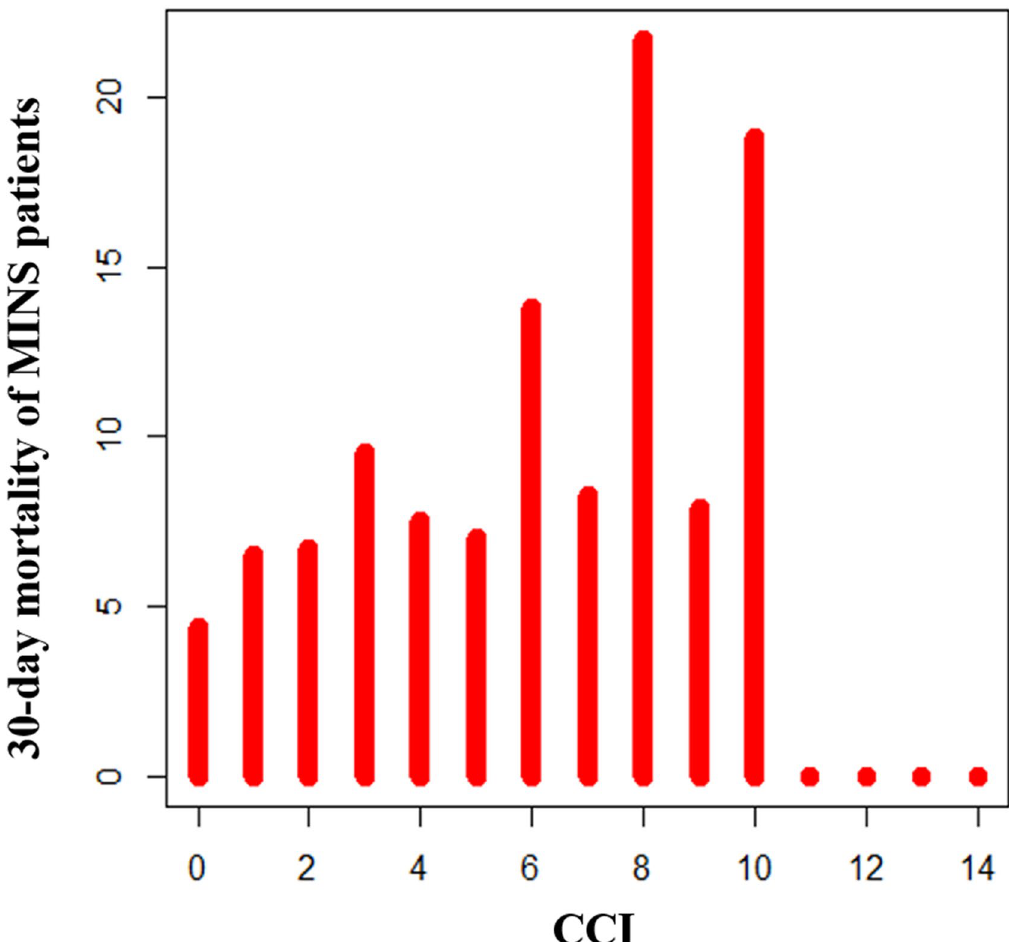
Figure 3. Histogram showing the association between CCI as a continuous variable and 30-day mortality of MINS.